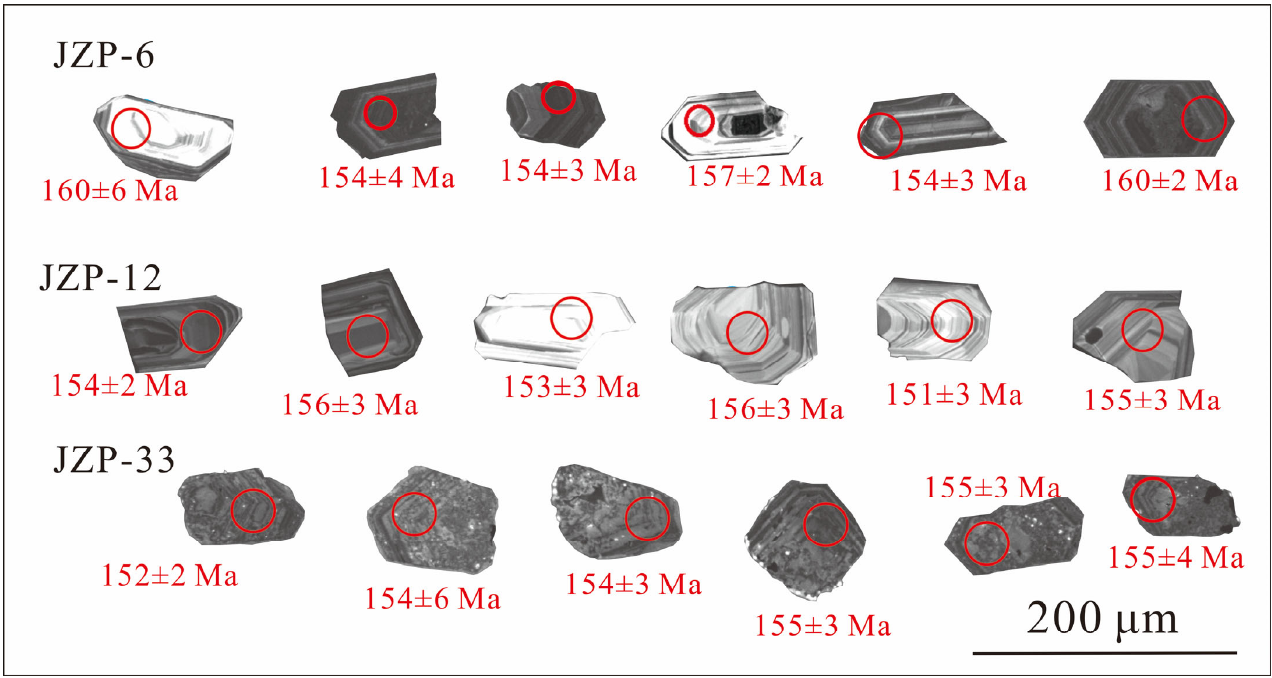
Figure 7. Cathodoluminescence (CL) images of zircon crystals from the Jinzhuping pluton. Twenty-two zircon grains from sample JZP-6 were examined, and their U and Th concentrations varied from 118.2 to 20583.2 ppm (mean 3985.5 ppm) and from 66.5 to 1801.3 ppm (736.3 ppm), respectively, and the U/Th ratios varied from 1.1 to 10.8 (Table 2). These characteristics indicate a magmatic origin for the zircon grains. Sixteen spots of the zircon grains (from JZP-6-6 to JZP-6-22) were used, because the other six analyses yielded very high-U contents that would result in inaccurate U–Pb age calibrations [51]. These analyses yielded a concordant age of 155.2 ± 0.68 Ma (MSWD = 0.8) (Figure 8A), which coincided well with the weighted mean 206 Pb/ 238 U age of 155.5 ± 1.3 Ma (MSWD = 0.96) (Figure 8B). This age represents the crystallization age of the main-phase biotite granite. Twenty-two zircon grains from sample JZP-12 were examined, and their U and Th concentrations varied from 80.6 to 482.9 ppm (mean 246.1 ppm) and from 54.4 to 318.6 ppm (154.6 ppm), respectively, and the U/Th ratios varied from 0.9 to 2.4 (Table 2). These char- acteristics indicate a magmatic origin for the zircons. These analyses yielded a concordant age of 154.0 ± 0.56 Ma (MSWD = 4.3) (Figure 8C), which coincided well with the weighted mean 206 Pb/ 238 U age of 153.8 ± 1.1 Ma (MSWD = 0.6) (Figure 8D). This age represents